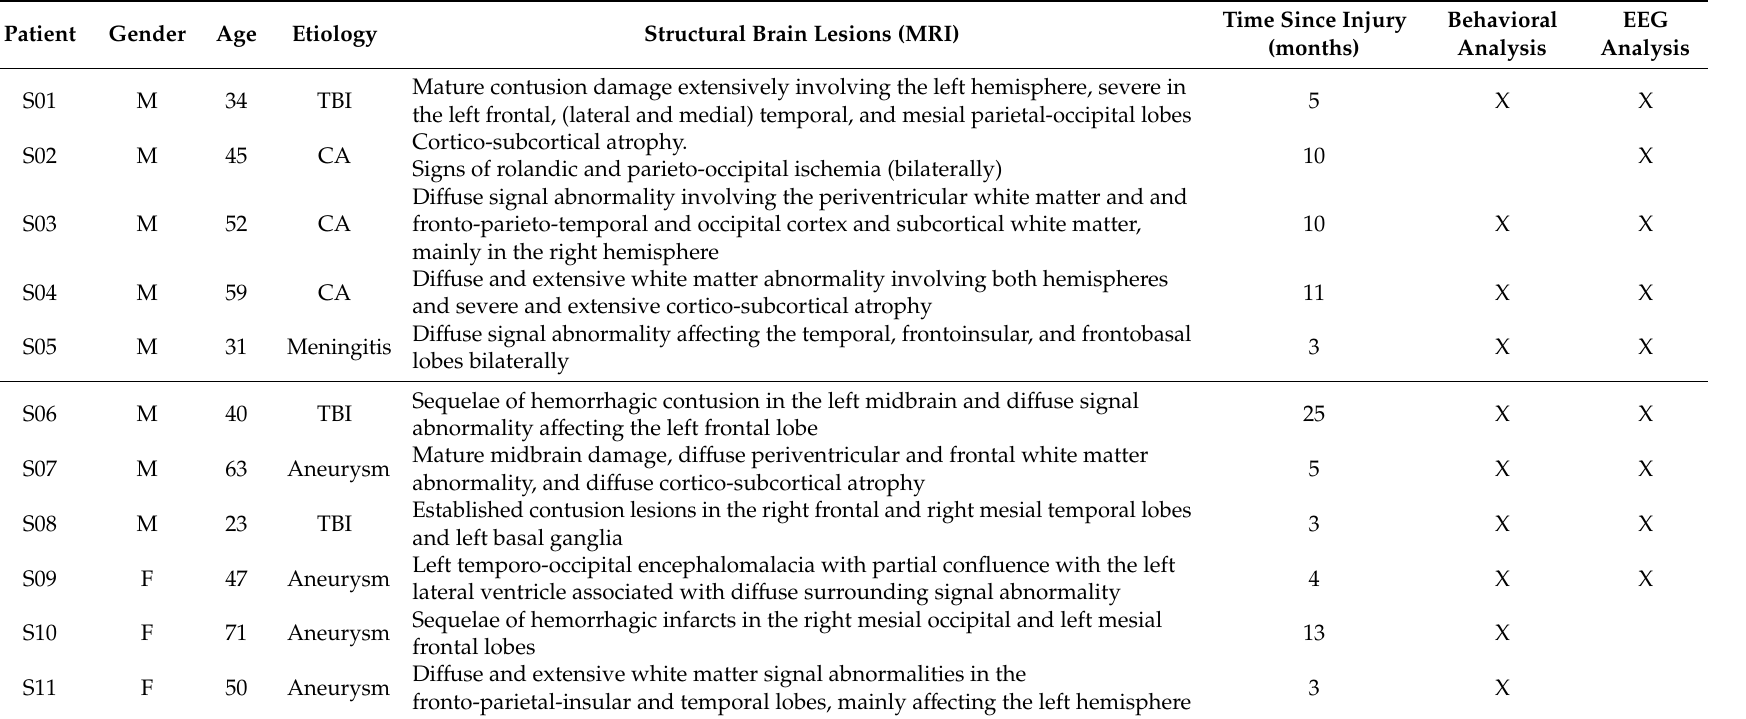
Table 1. Demographic data of the eleven patients included in the